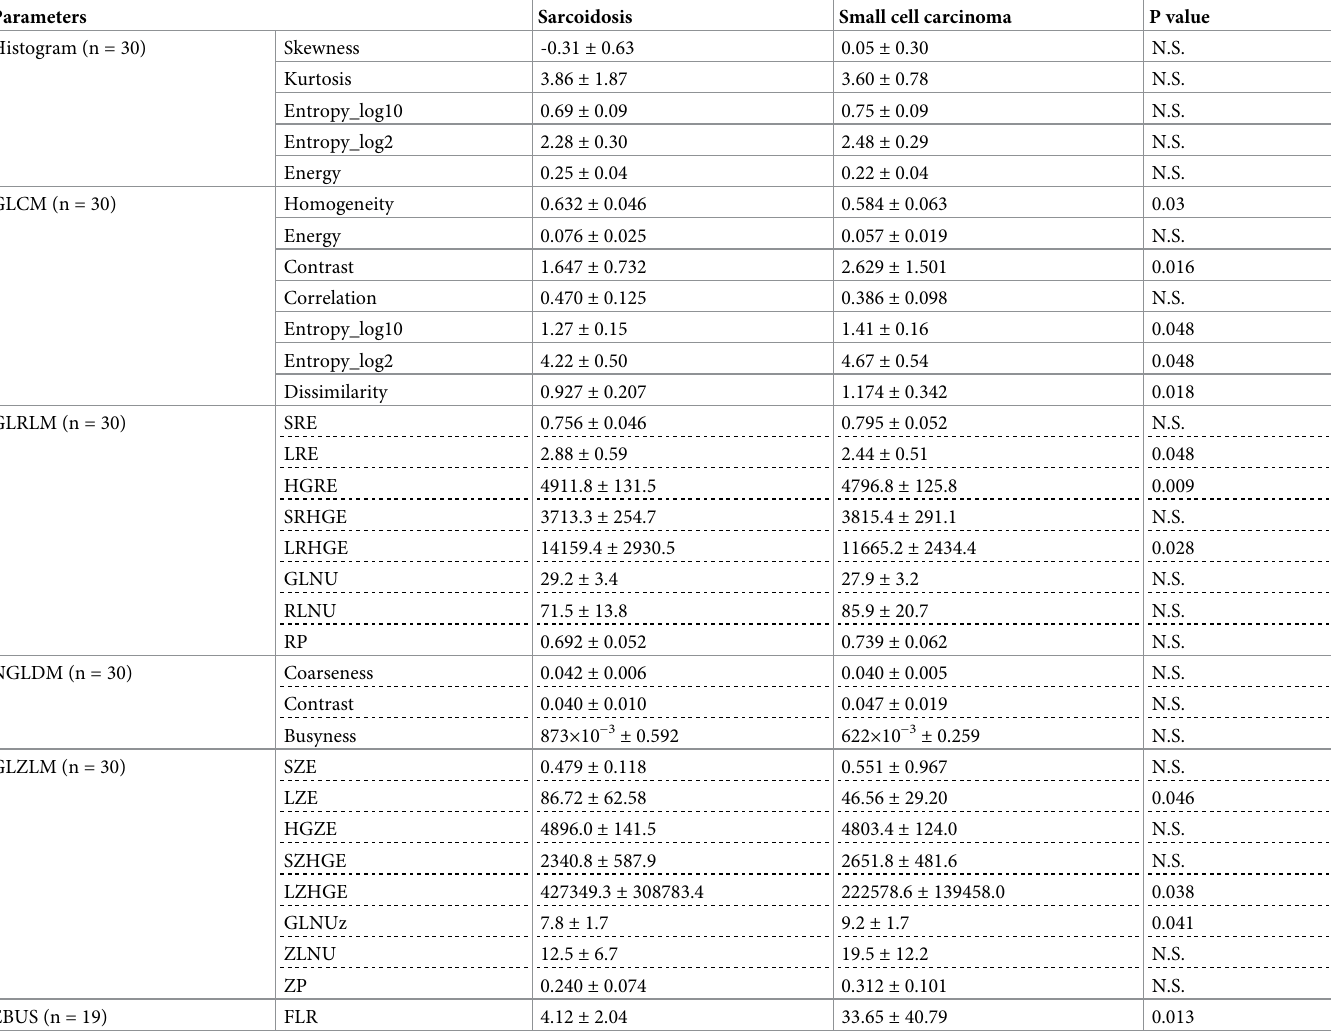
Table 2. Radiomics features of lymph nodes affected by sarcoidosis versus the features of lymph nodes affected by small cell carcinoma.